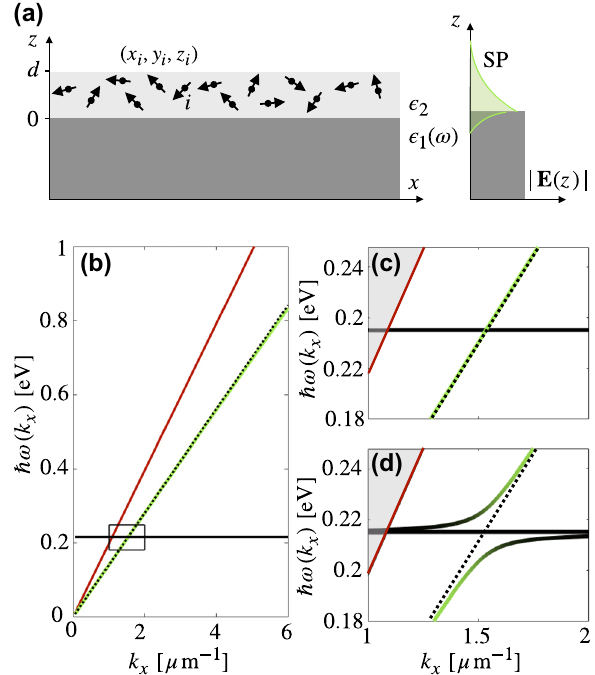
Figure 2: Strong coupling of molecules to a surface plasmon: (a) Schematic showing transition dipoles in a slab of thickness d on a metal plate which we consider to have infinite thickness. An SP can propagate at the metal/dielectric interface. (b) The dispersion relations of an SP at a gold/PMMA interface and N uncoupled C = O units. The red line gives the light-line in air, and the dotted line gives the light-line in PMMA. (c) Zoom-in of the region where the dispersion relations overlap, and (d) the dispersion relation with strong coupling. N ∕ A = 70 nm − 2, d = 2 μ